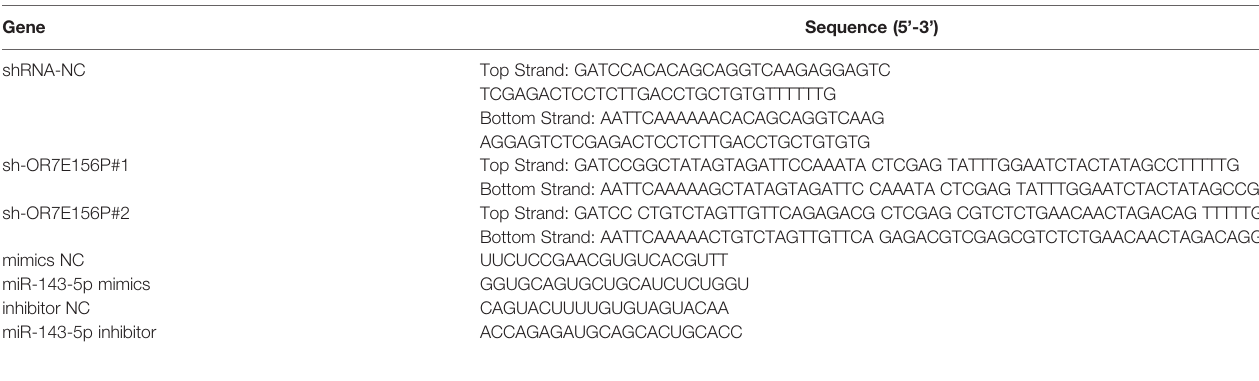
TABLE 1 | The sequence of shRNA OR7E156P and miR-143-5p mimics and